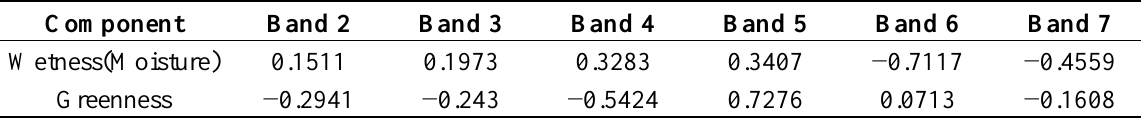
Table 3. Moisture coefficients of TCT for Landsat 8 OLI data